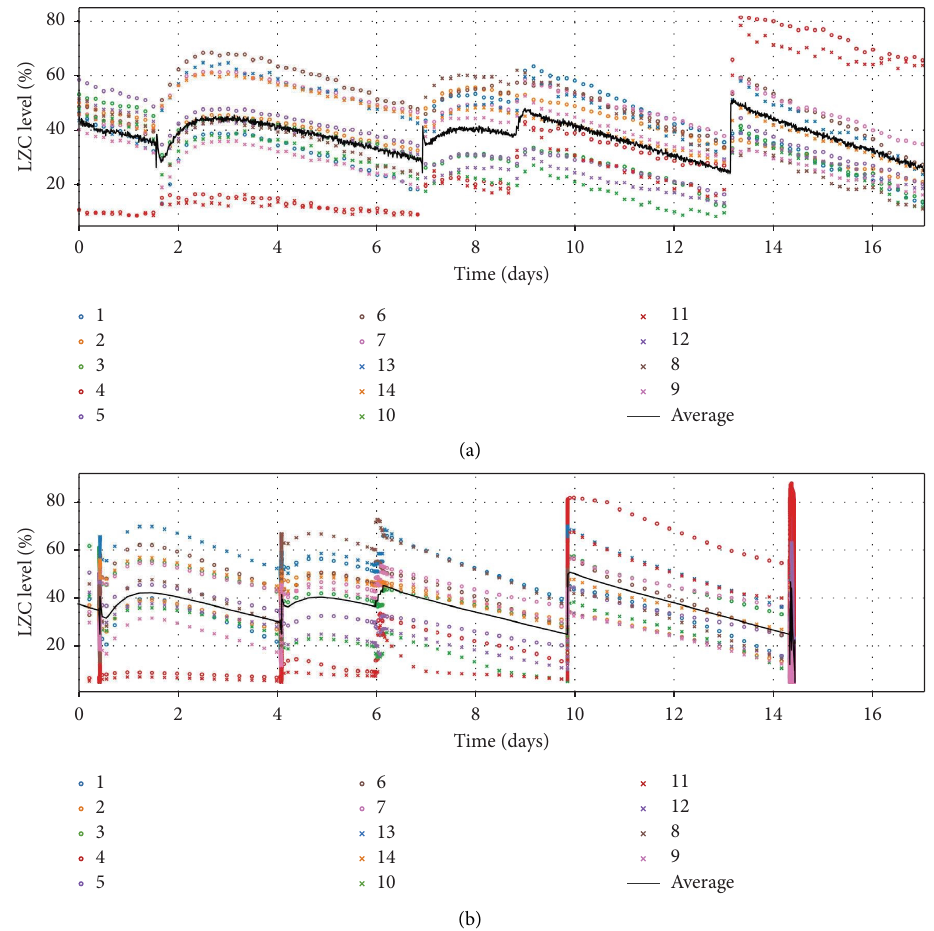
Figure 6: Evolution of simulated shim operation: station (a) versus reference case